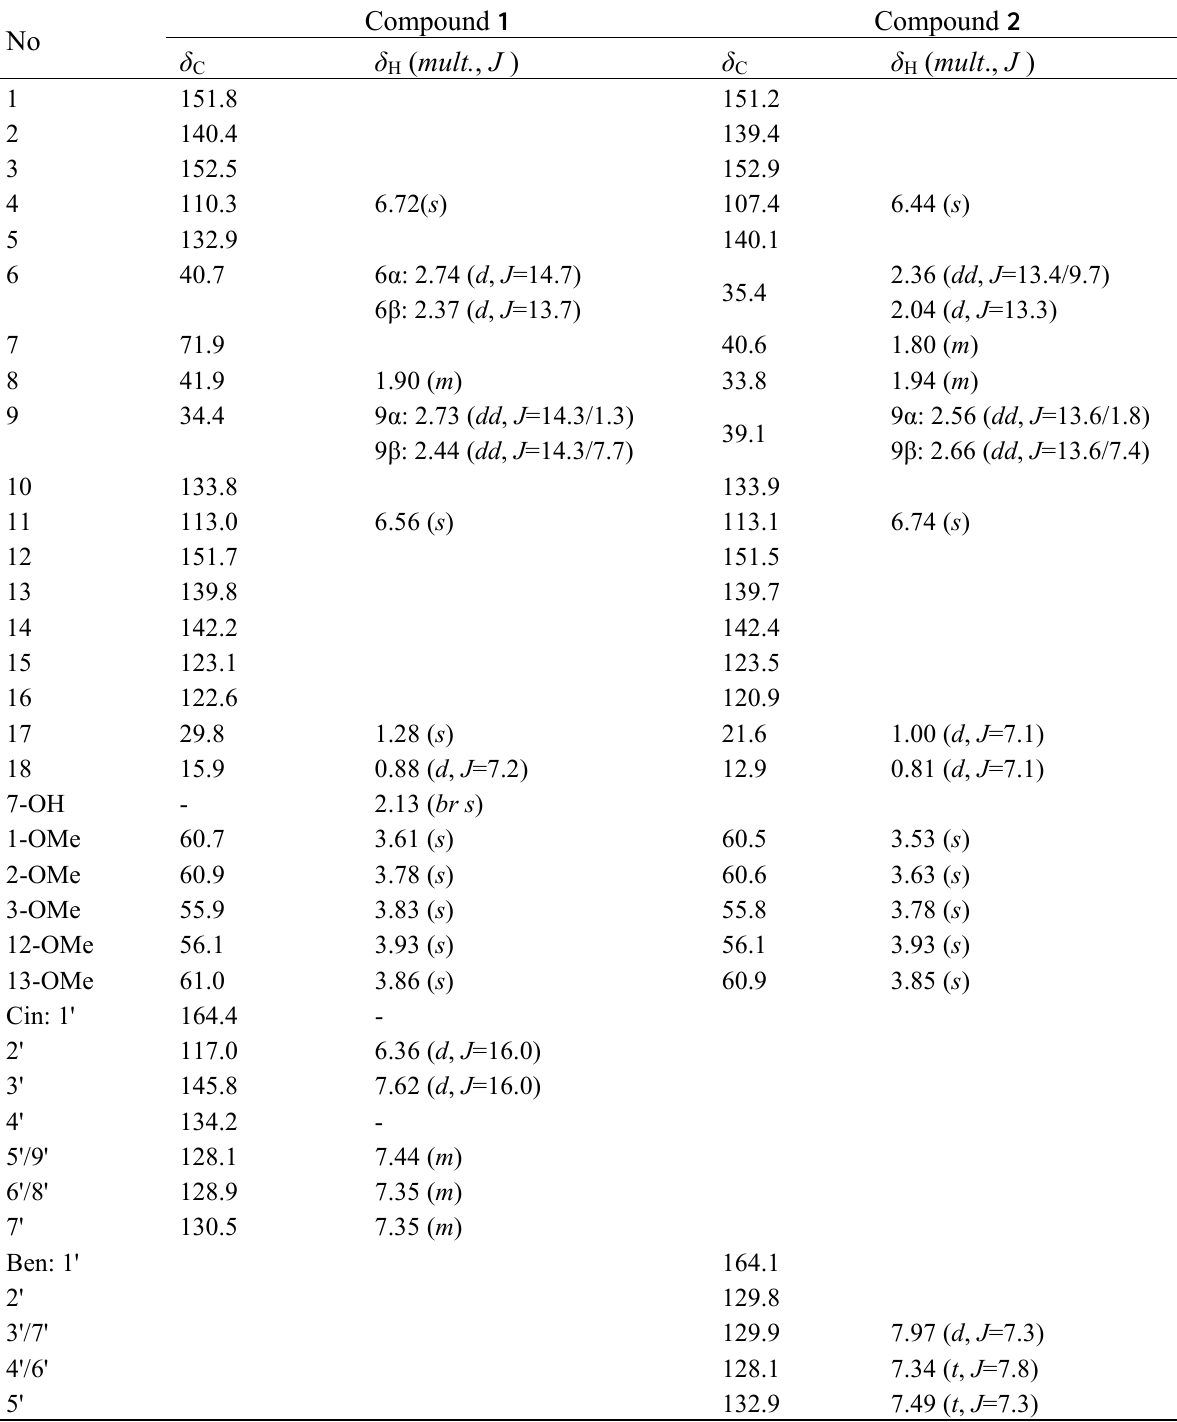
( δ in ppm, J in Hz). 3